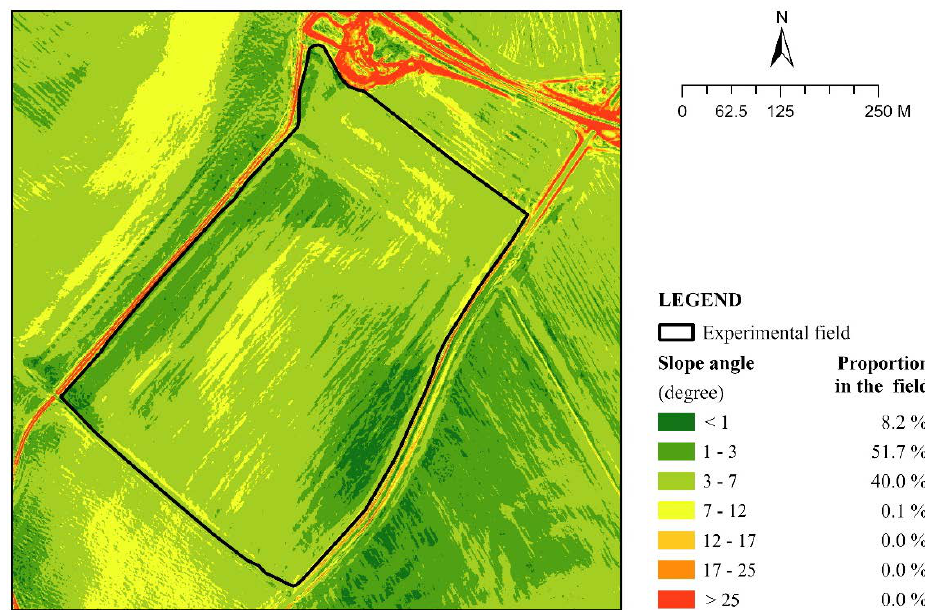
Figure 6. Slope angle in the experimental field (determined from the raw data [33]).